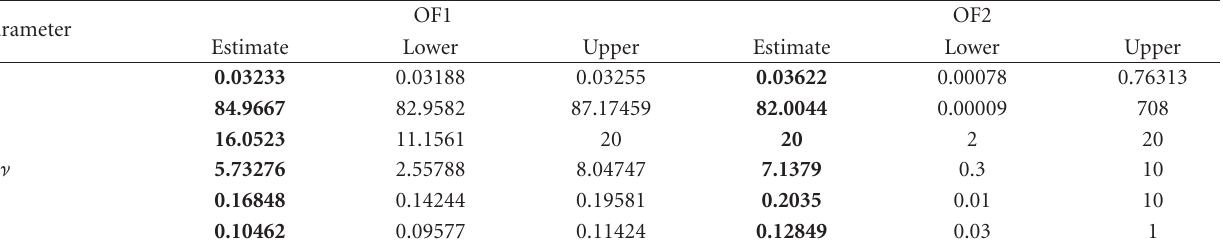
Table 6: A comparison of results found using OF1 and OF2 on the parameter estimates and 95% confidence intervals for data of November based on model